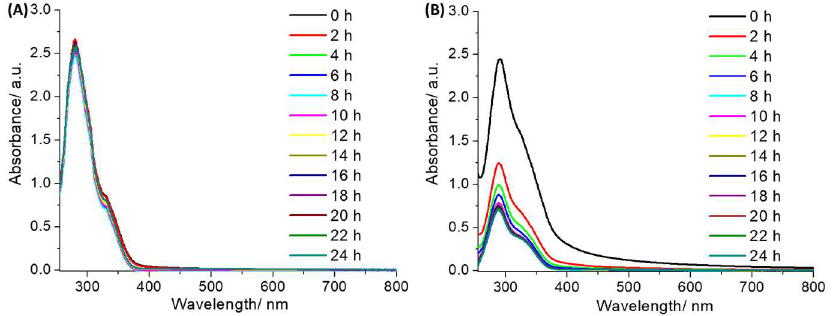
Figure 2. UV-Vis spectra of ( A ) 1 and ( B ) 2 (both 50 µM) in Dulbecco’s Modified Eagle Medium (DMEM):DMSO (200:1) over the course of 24 h at 37 °C. Table 1. IC 50 values of 1 , flufenamic acid, cisplatin, carboplatin and salinomycin against U2OS and U2OS-MTX cells and U2OS-MTX osteospheres determined after three or 10 days incubation (mean of two or three independent experiments ±